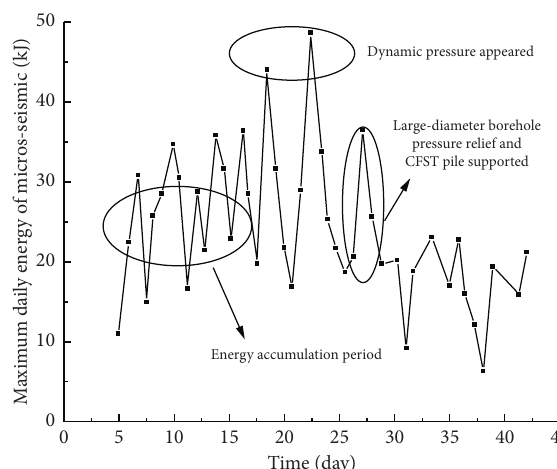
Figure 21: Statistical analysis of microseismic energy and